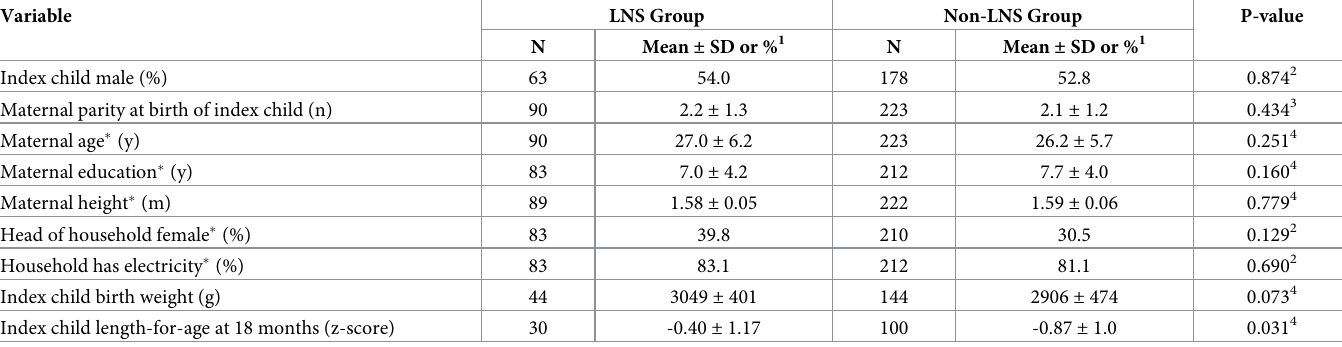
Table 3. Characteristics of lost to follow-up sample by intervention